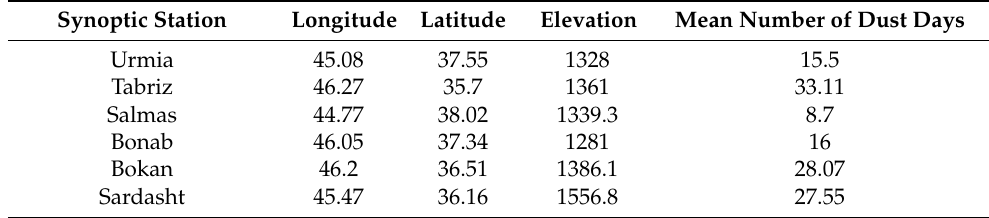
Table 1. The six synoptic weather stations around Lake Urmia and the mean annual number of dust days during 2000–2017.